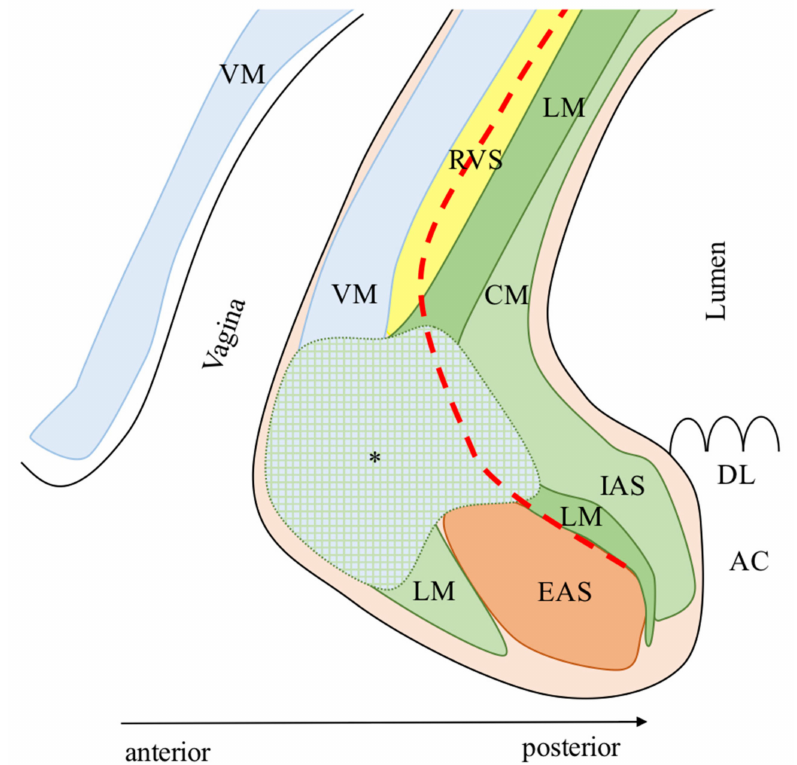
Figure 3. Female’s anterior anatomy. AC: Anal canal; CM: Circular muscle of the anal canal; DL: Dentate line; EAS: External anal sphincter; IAS: Internal anal sphincter; LM: Longitudinal muscle of the anal canal; RVS: Rectovaginal septum; *: Area of intermingling between muscle fibers of the LM, the VM, and the IAS; VM: Vaginal smooth muscle layer; Red line: Dissection plane during intersphincteric resection. The anatomic model was designed according to the descriptions of Muro et al. [33]. Modified and reprinted with permission from ref. [20]. Copyright 2020 Turkish Journal of Colorectal